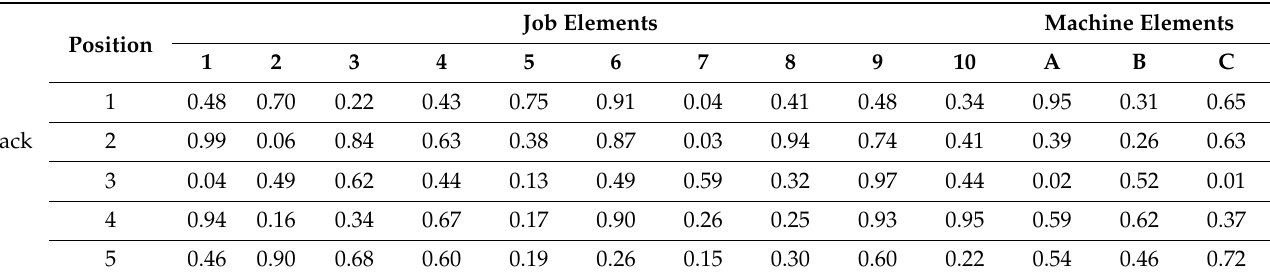
Table 1. Example of a set of five tracks used in